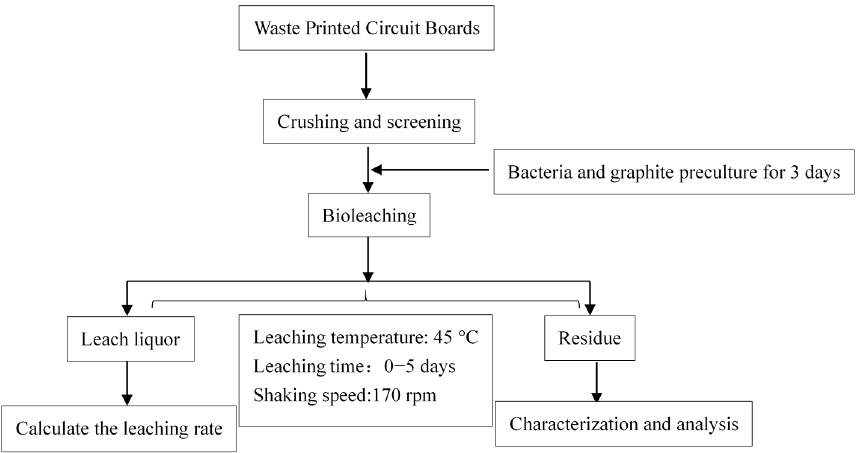
Figure 2. Flow diagram of conducted experiments to evaluate graphite function in WPCB copper bioleaching.